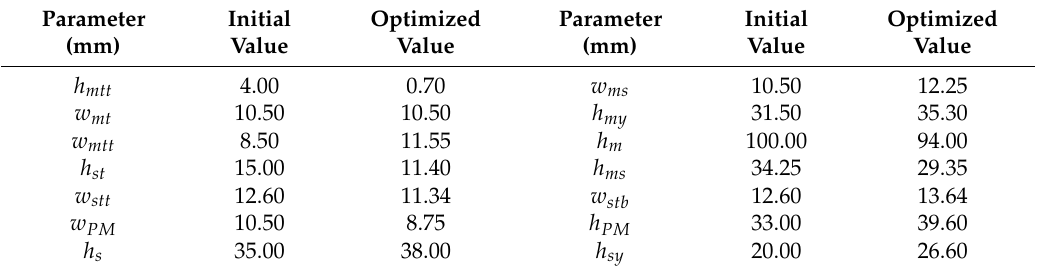
Table 14. Comparison of initial and optimized geometric